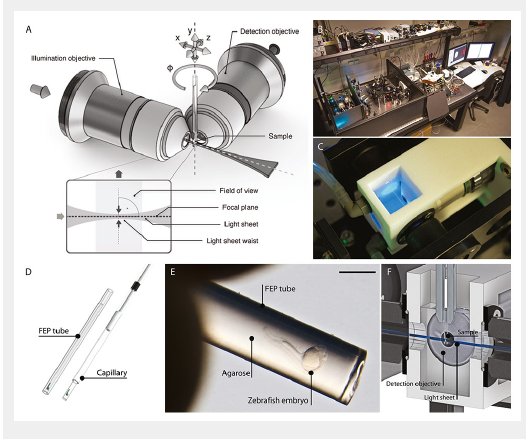
A: The principle of light sheet microscopy. Top: Illumination and detection objectives are oriented orthogonally, and the sample is placed at the intersection of their focal planes. A sheet of laser light illuminates a thin slice of the sample. Bottom: View from top. The light sheet has a waist in the centre of the field of view and overlaps perfectly with the focal plane of the detection objective. B: Custom- built light sheet microscope for imaging and photomanipulation of the zebrafish heart. C: Close-up of the medium-filled sample chamber with a blue light sheet. D: Sample mounting for in vivo cardiac optical mapping. Comparison of zebrafish embryos mounted in fluorinated ethylene propylene (FEP) tube and glass capillary. E: 1 dpf (days post-fertilisation) zebrafish mounted in FEP tube. F: Rendering of a mounted zebrafish embryo held by the sample holder inside the imaging chamber with illumination objectives, light sheet and detection